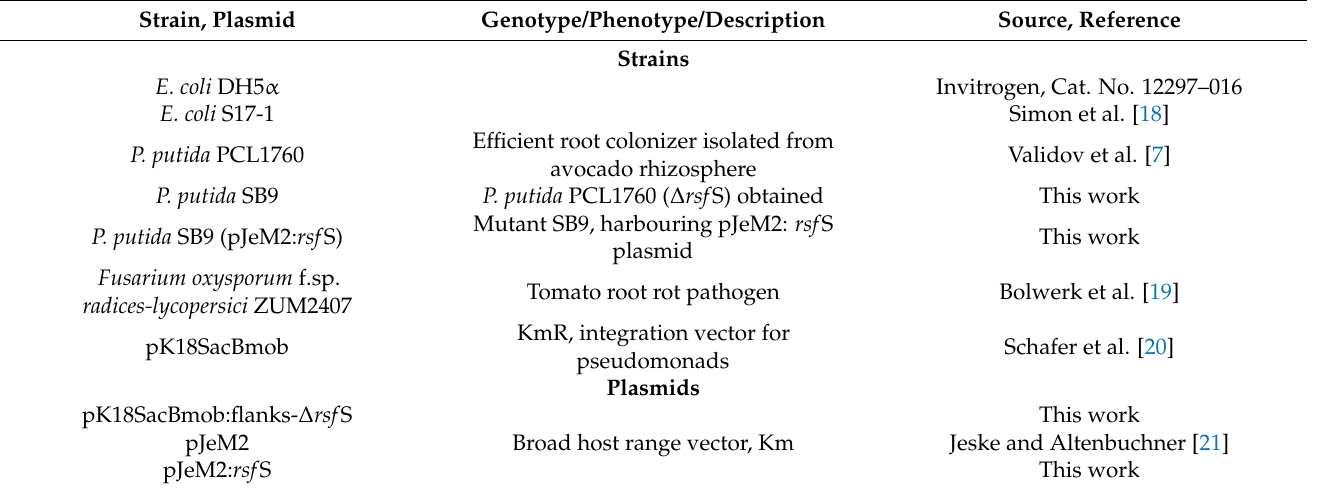
Table 1. The microbial strains used in this study.